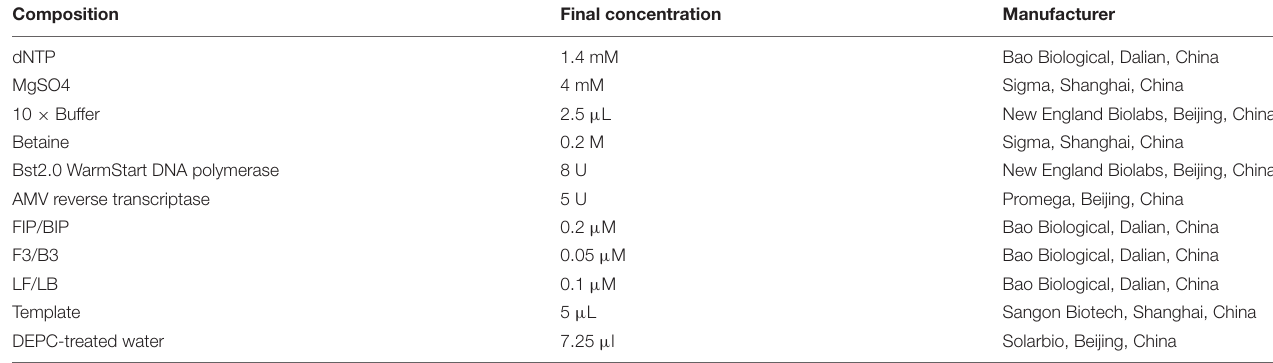
TABLE 3 | Reaction system of RT-LAMP-VF assay.